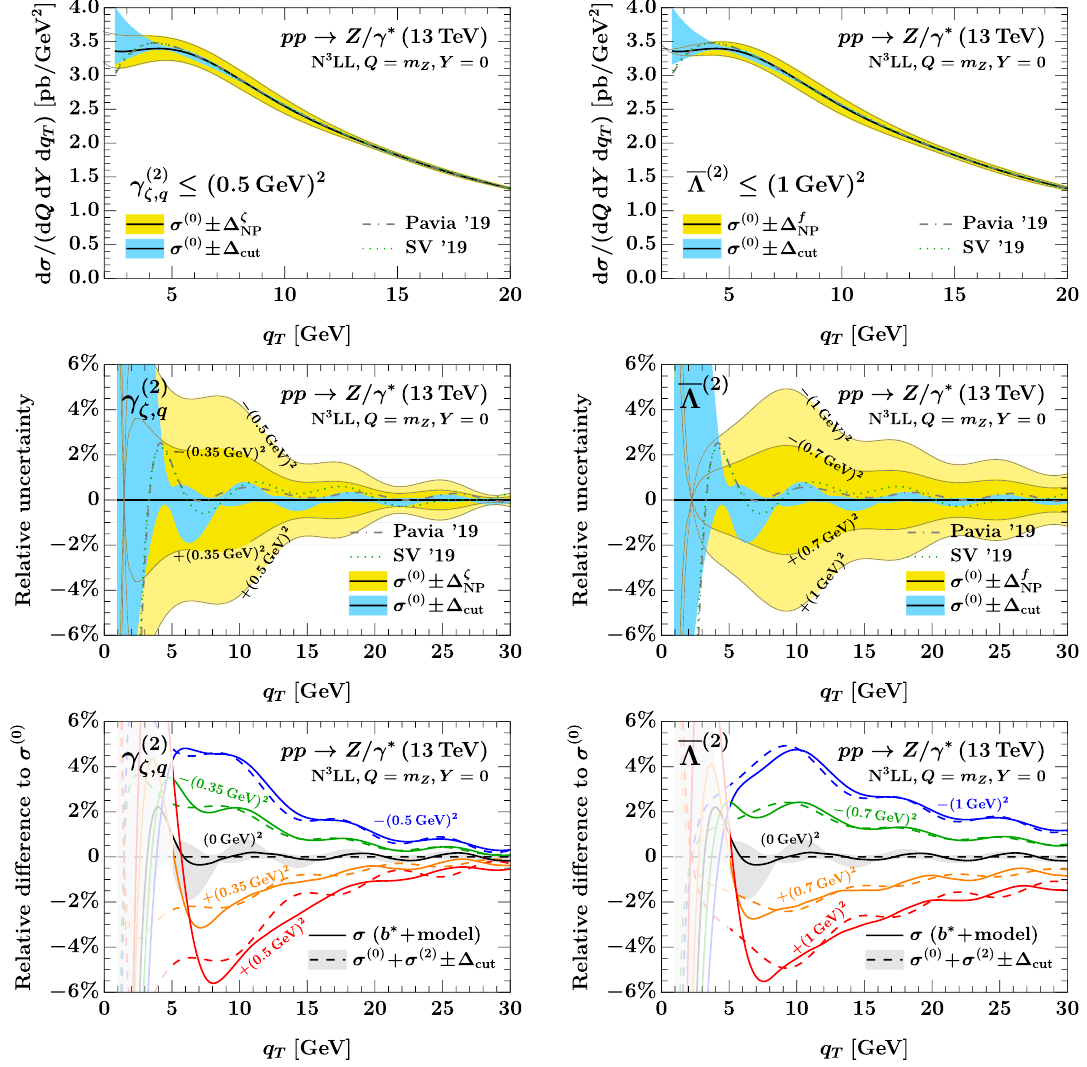
Figure 11 . Impact plots of quadratic OPE parameters in the LHC Drell-Yan cross section interpreted as nonperturbative uncertainties (top and middle row) or fits to data (bottom). We consider the impact of the quadratic coefficient in the rapidity anomalous dimension (left column) and the intrinsic TMD PDF averaged over hard phase space (right column) on the physical N 3 LL cross section. Our averaging procedure for the intrinsic TMD PDF coefficient Λ eq. (4.11) and discussed there. We generate mock data (solid lines in bottom row) as described around eq. (4.15). For clarity the uncertainty band for ∆ cut (light blue band in bottom and middle row, gray in bottom row) is only shown for the central fit template in the bottom row. For nonzero values of the nonperturbative parameters of interest, the band looks essentially identical. All OPE results use a third-order functional S (3)